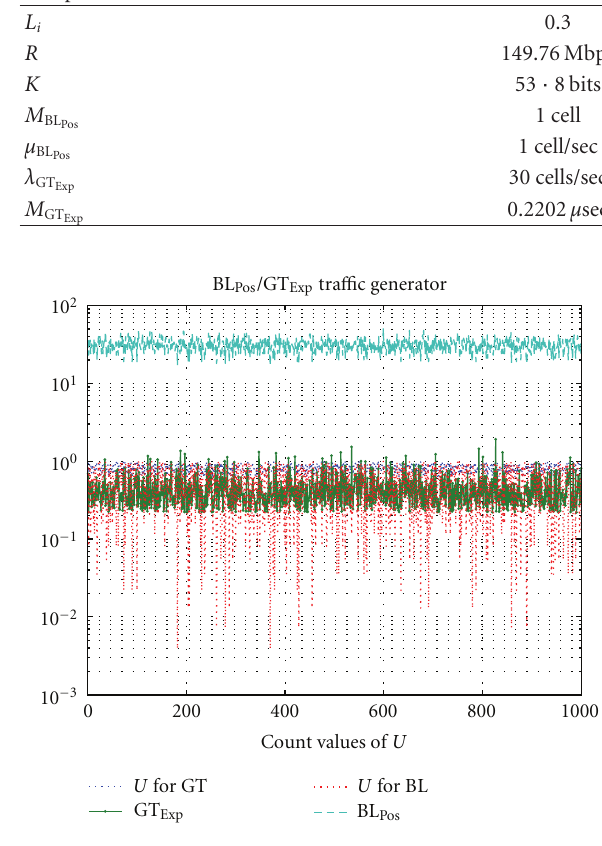
Figure 1: BL Pos / GT Exp tra ffi c generator for 1000 count values of U .